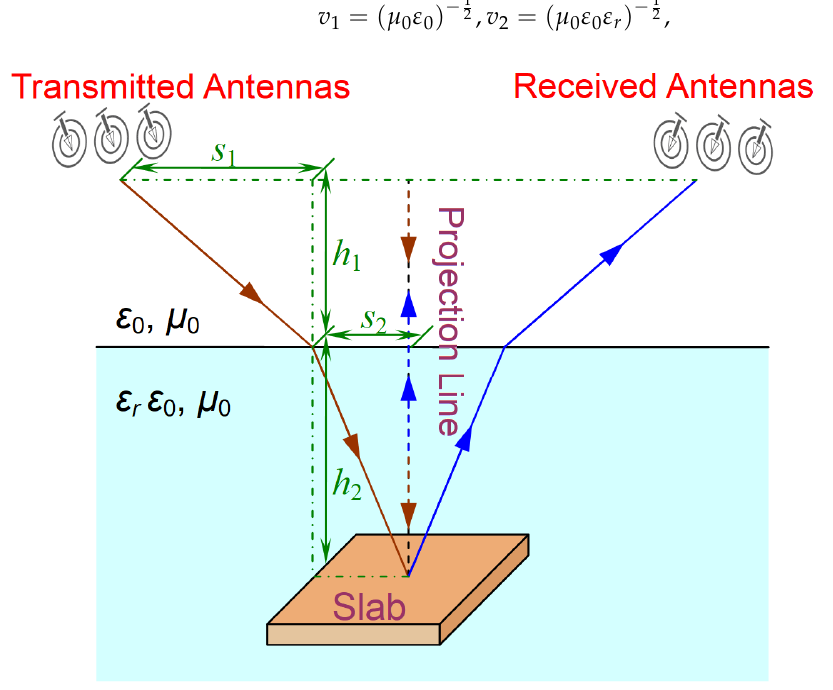
Figure 7. Diagram of the electromagnetic path and the projection line, which are marked by the solid line and the dash line, respectively.